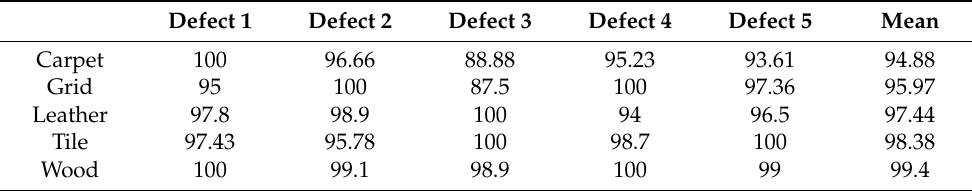
Table 10. CCP results obtained with one class SVMs for all